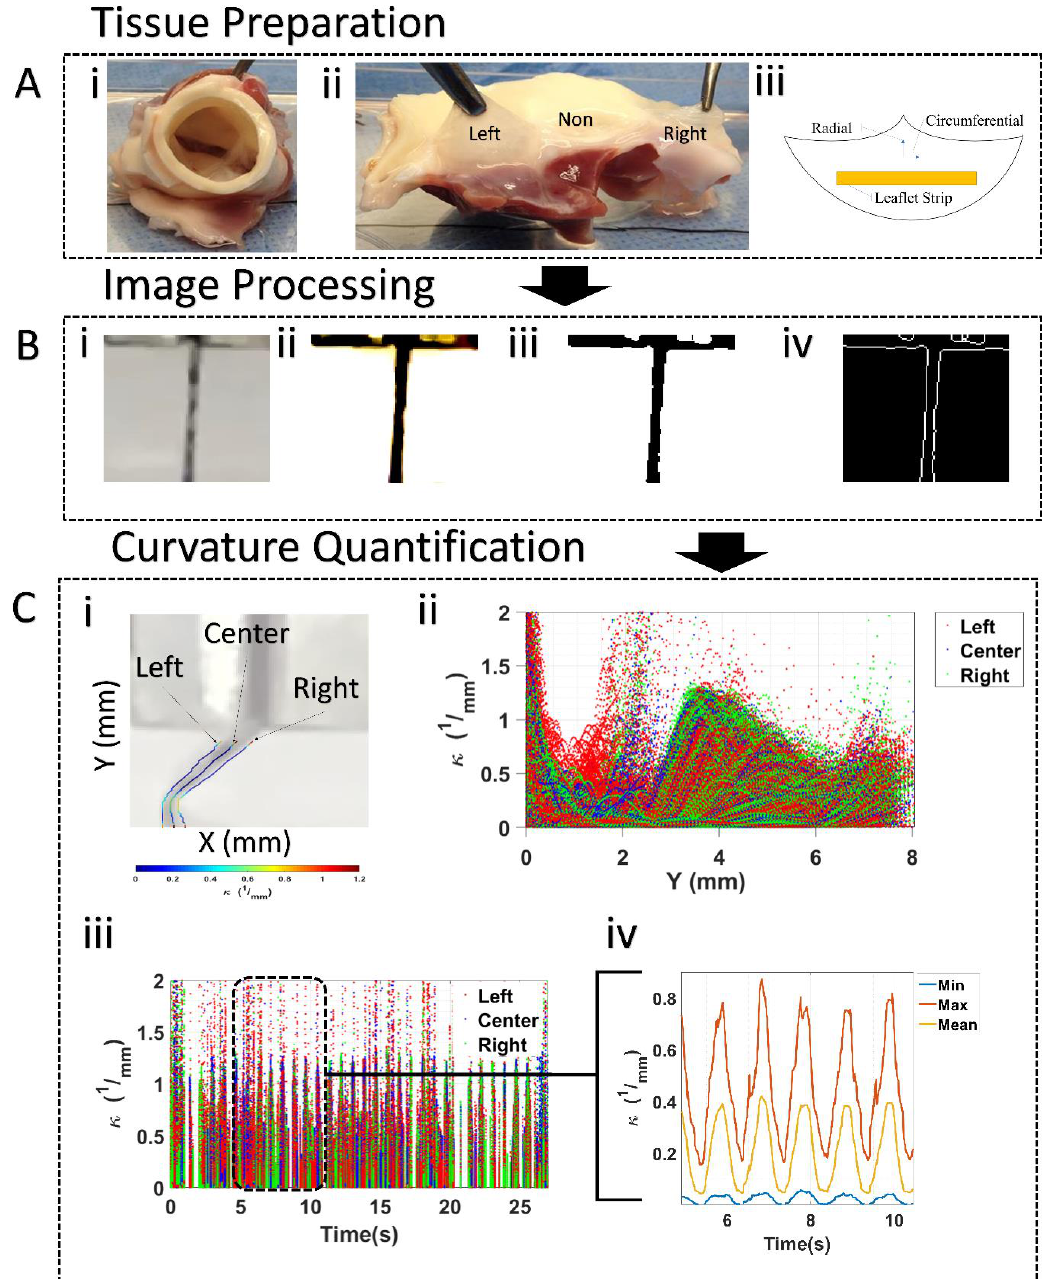
Figure 2. Workflow ( A ) Tissue preparation: i) Porcine aortic valve, ii) split aortic valve revealing the three leaflets, iii) schematic of circumferentially oriented rectangular strips cut from the belly region of porcine aortic valve leaflets. The remaining surrounding tissue was minced and used for the degradation and quantification of elastin in this study. ( B ) Image processing: i) Cropped image according to region of interest, ii) increase background to foreground contrast, iii) threshold image, iv) edge detection. ( C ) Curvature quantification: i) Left / center / right curvatures for a frame of a video, ii) temporal curvature for a given leaflet, iii) spatial curvature for a given leaflet, iv) minimum, Maximum, and mean curvature along center profile for the 5–10